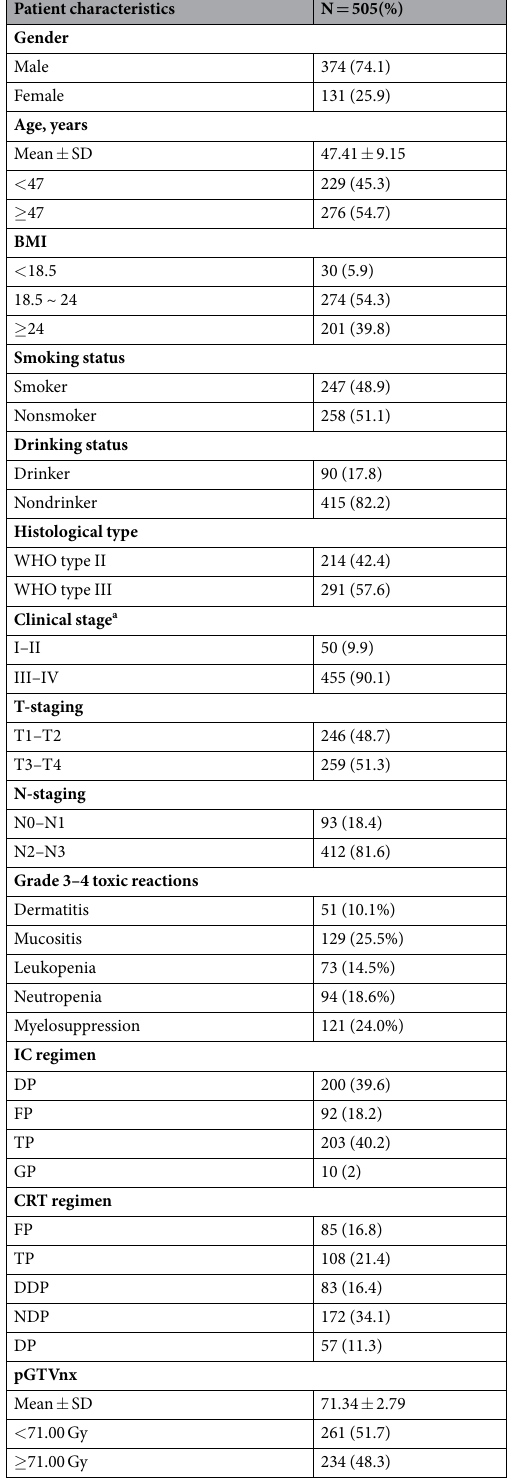
Table 1. Patient demographics and clinical characteristics. Abbreviations: BMI, Body Mass Index; IC regimen, Induction chemotherapy regimens; CRT regimen, concurrent chemoradiotherapy regimen; pGTVnx, irradiation